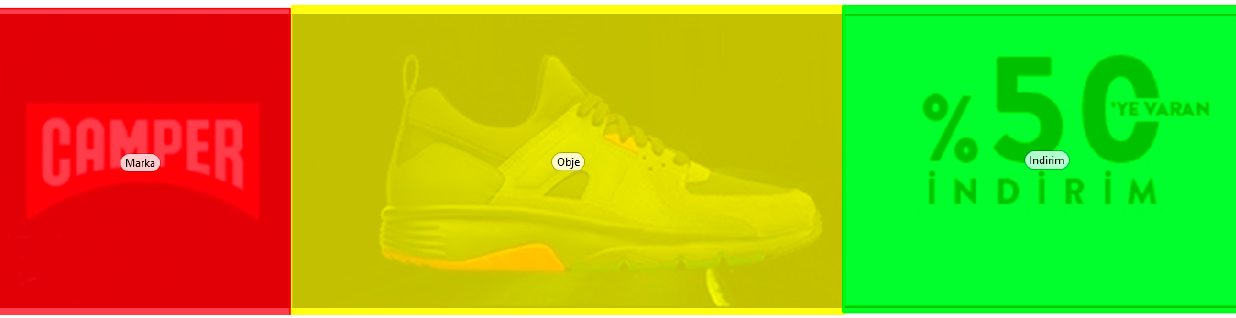
Figure 1. Areas of Interest (AOIs) for banner 2b.